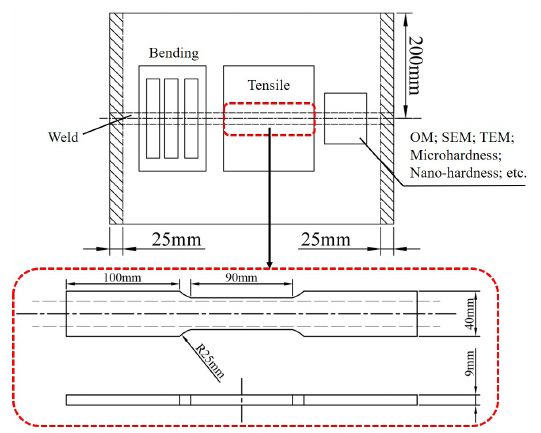
Figure 1. Sampling